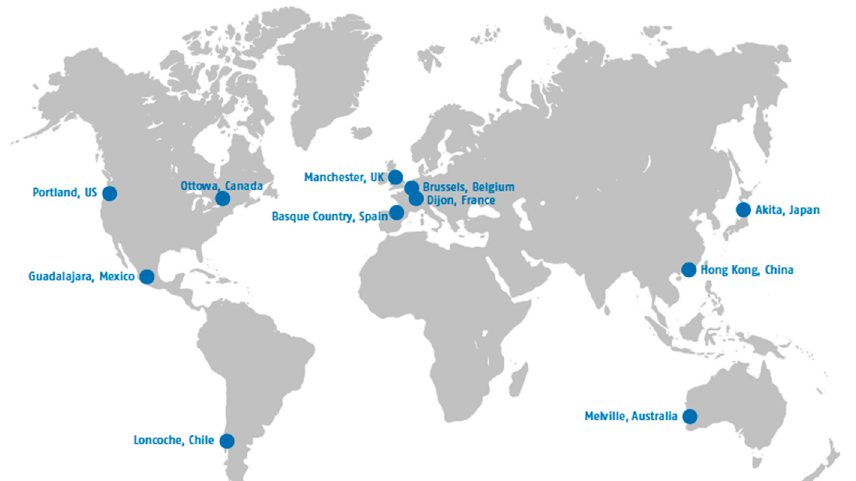
Figure 2. Map of selected cities .